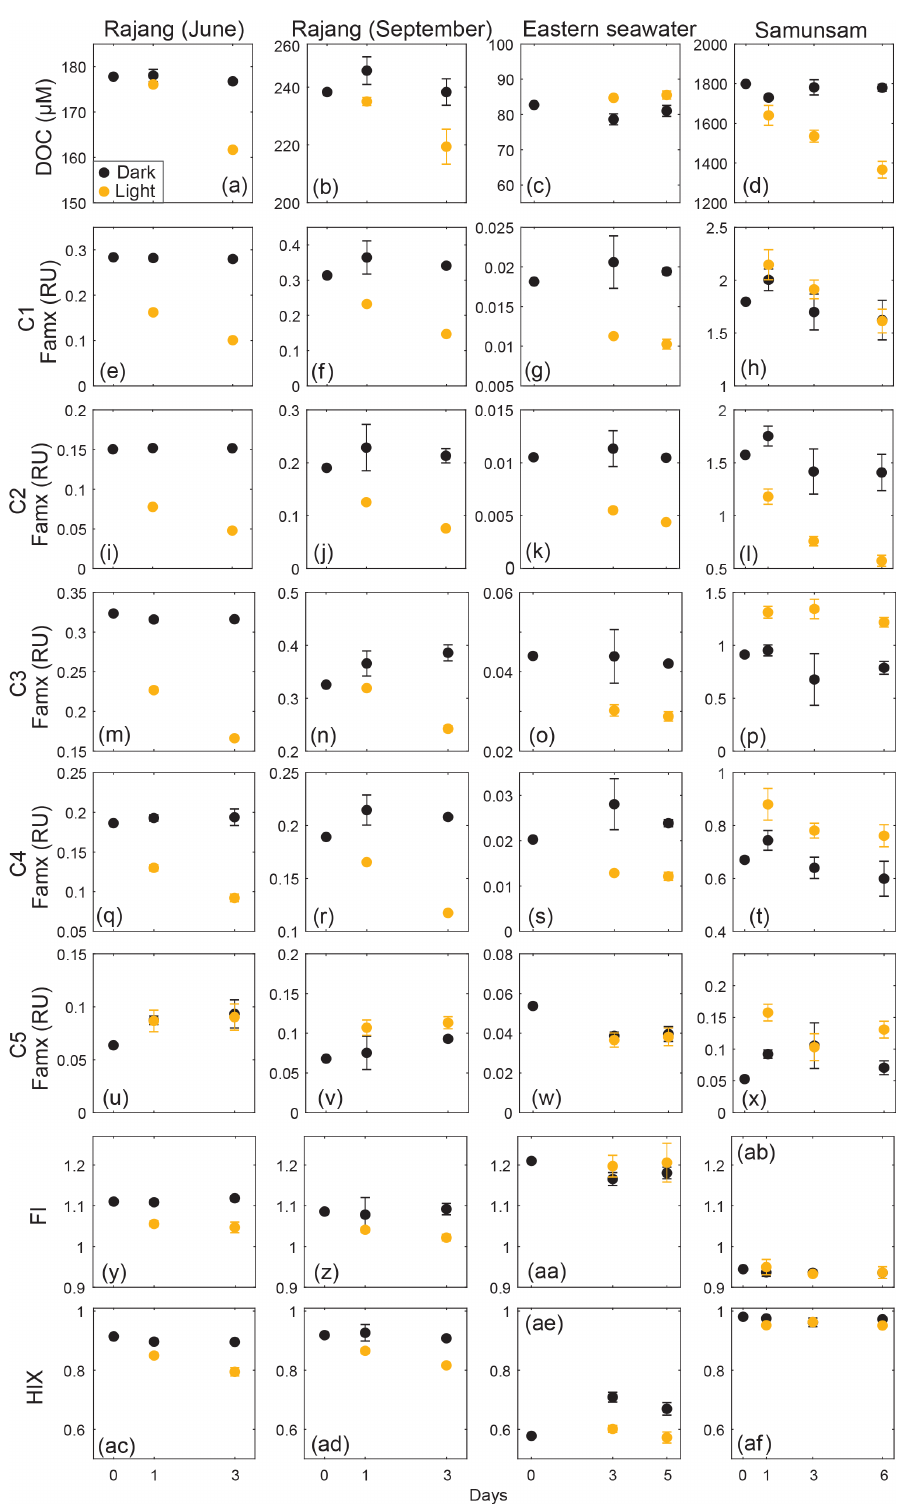
Figure 5. Changes in DOC (a–d) , C1–C5 Fmax (e–x) , FI (y–ab) and HIX (ac–af) of samples from Rajang River in June and September, from seawater of eastern region and from Samunsam River during the photodegradation experiment. DOC data are taken from Martin et al.